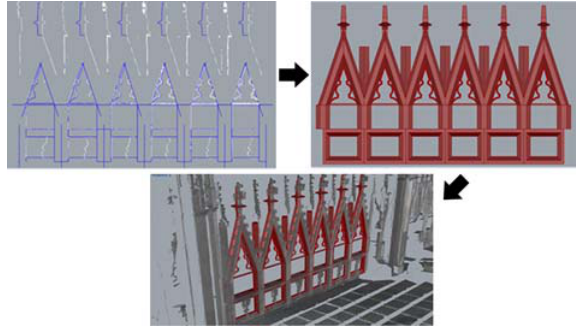
Figure 7. Starting from the point cloud, it was necessary to trace every section and model every single element, even if in this case the objects are similar, with only different dimensions: it was not possible to model one arch and adjust the others on the existing one.